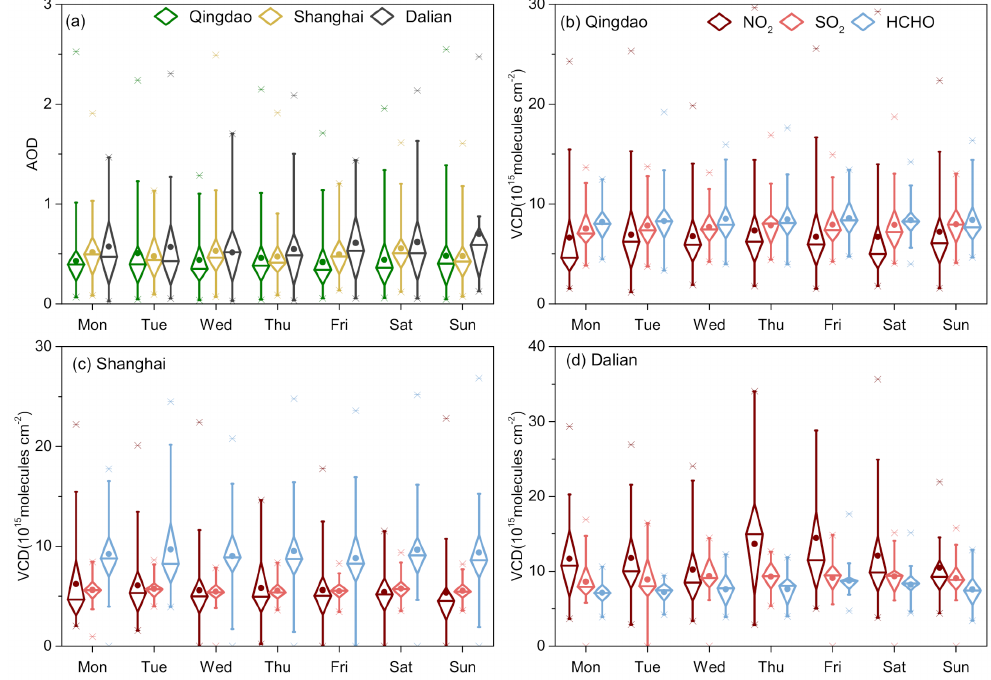
Figure 7. Mean weekly cycles for ( a ) AOD in three sites, and NO 2 , SO 2 , and HCHO VCDs in ( b ) Qingdao, ( c ) Shanghai, ( d )